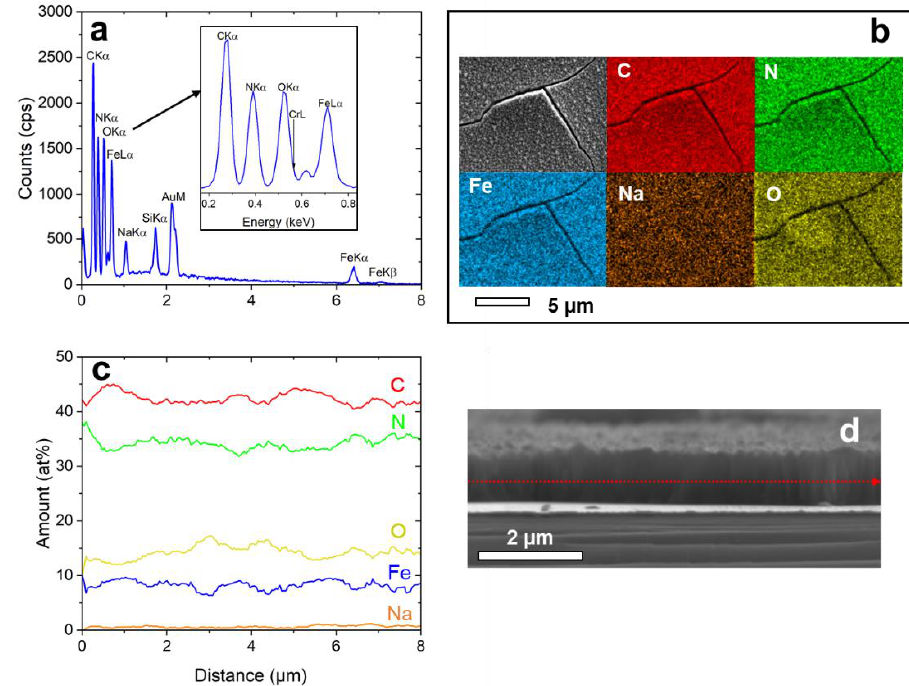
Figure 4. EDX-analysis of NaFeHCF measured at 10 keV: ( a ) EDX spectrum taken from the area in ( b ), ( b ) elemental maps of the homogeneously distributed elements, ( c ) Elemental composition obtained by line-scan analysis along the marked line in ( d ), ( d ) SEM cross-section image of the investigated sample region used for line-scan analysis.